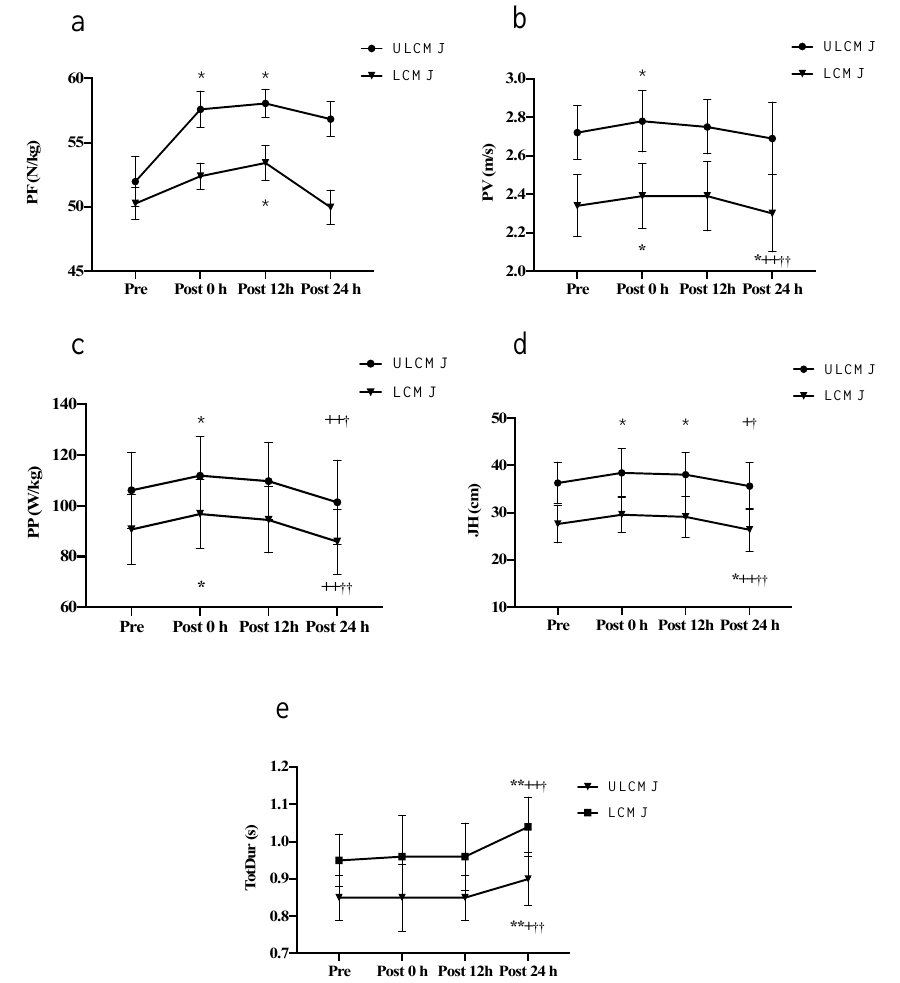
Figure 1. CMJ unloaded and CMJ loaded parameters at different points in time. *,** Significant compared with pre-test, p < 0.05, p < 0.001; +,++Significant compared with post-test at 0 h, p < 0.05, p < 0.001; †,†† Significant compared with post-test at 12 h, p < 0.05, p < 0.001. peak force, PF ( a ); peak power, PP ( b ); peak velocity, PV ( c ); jump height, JH ( d ); total duration, TotDur ( e ). Table 3. Correlation with the mRPE score and 0 h, 12 h, and 24 h Countermovement Jump Parameters. mRPE Variable